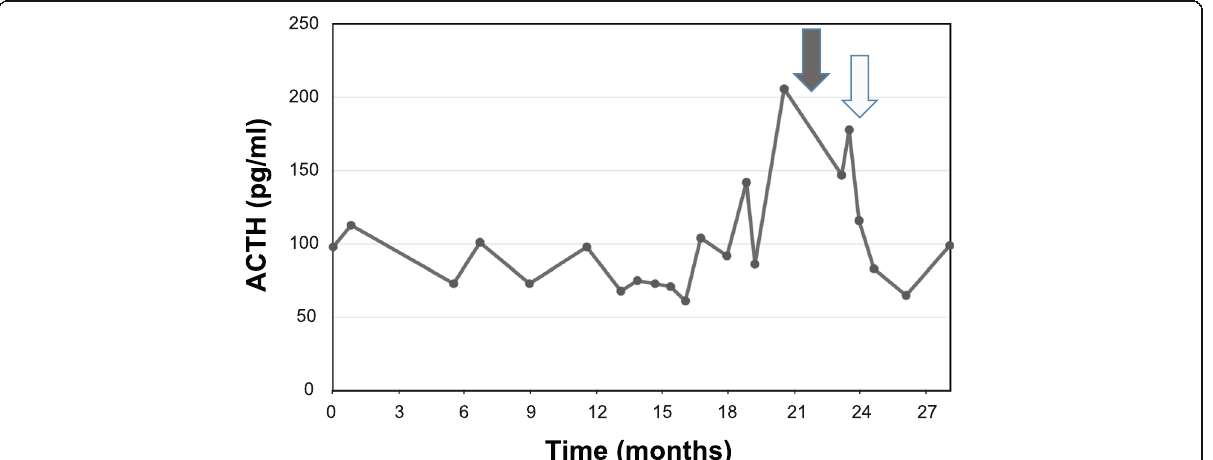
Fig. 3 Serum ACTH levels during the patient ’ s clinical course. Twenty-one months after the second pituitary tumor resection, there was a marked elevation of serum ACTH, despite stability of her sellar disease. This occurred immediately prior to discovery of her liver lesion ( dark arrow ). The serum ACTH abruptly declined after resection of the metastasis ( light arrow ). A similar decline in systemic ACTH has been previously reported following resection of a corticotroph carcinoma liver metastasis (19)